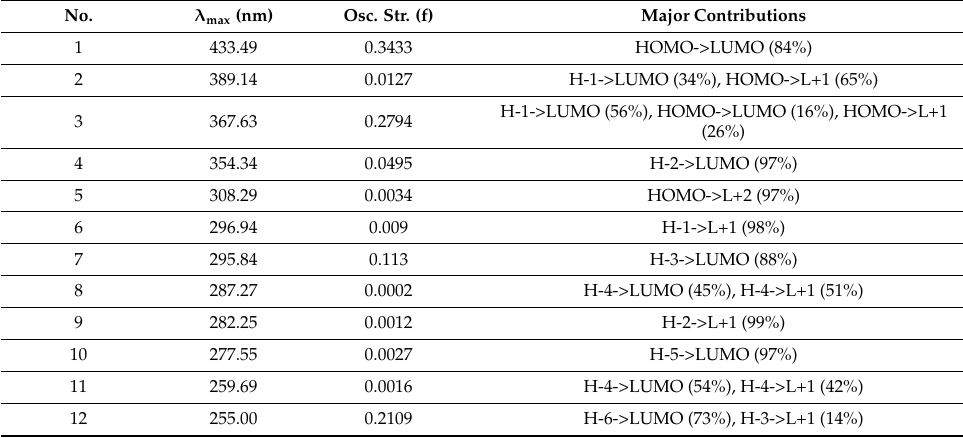
Table 5. TD-DFT computations parameters.